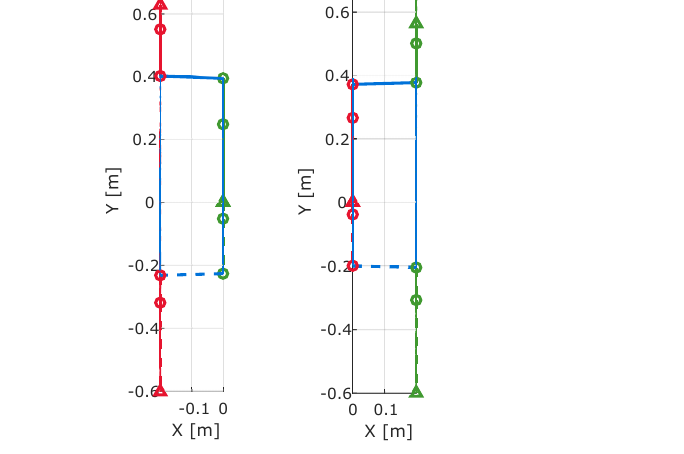
Figure 14. Top view of forward kinematics of skeletal model between toe-off and heel-strike: ( left ) Left limb swing and right limb stance. ( right ) Right limb swing and left limb